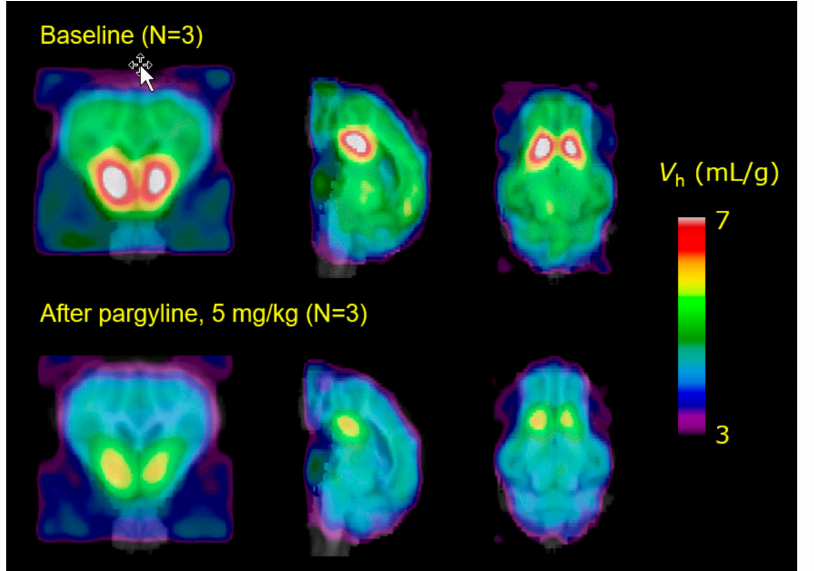
Figure 7. Mean parametric maps of the total distribution volume of 5-[ 11 C]-MeO-DMT ( 47 ) in brain of groups of three pigs at baseline and after treatment with the irreversible MAO A/B inhibitor, pargyline. There was no evidence of potentiation of the tracer uptake by blockade of MAO, nor was the binding in ventral striatum displaceable in studies with ketanserin ( 7 ) pretreatment (Jensen and Cumming, unpublished